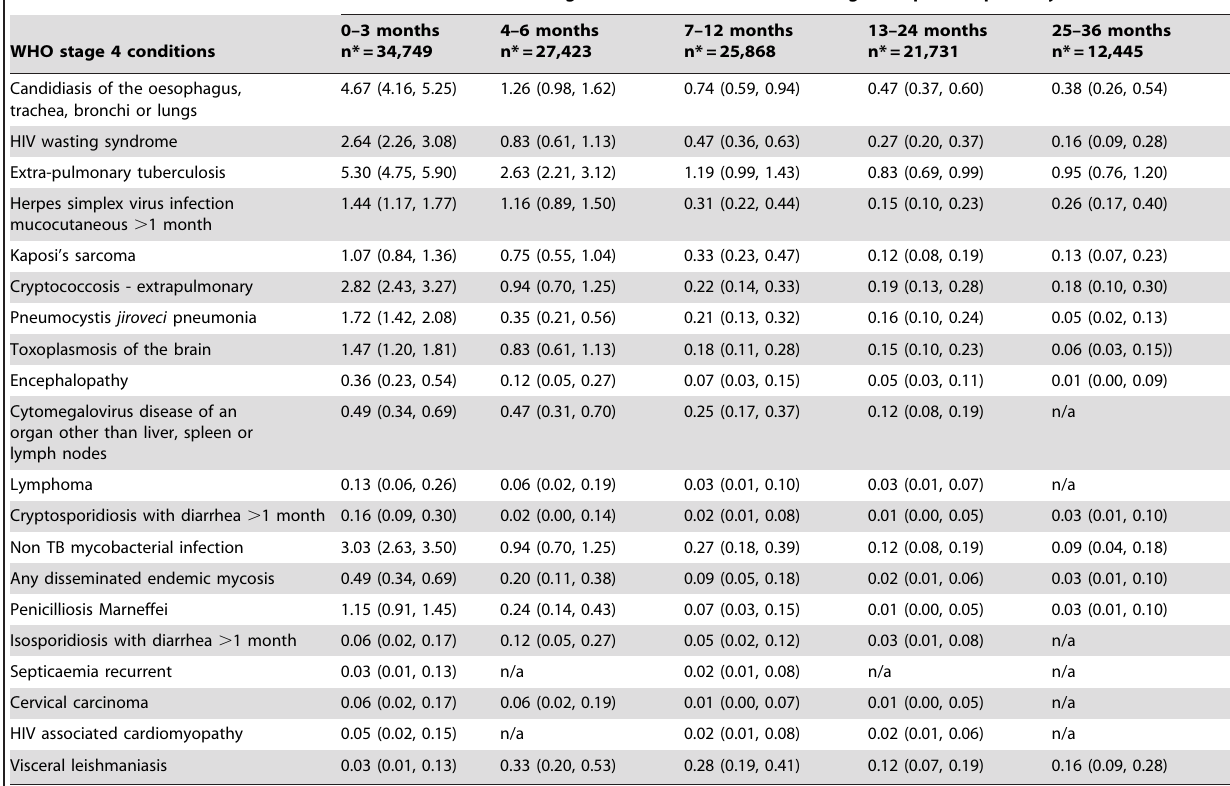
Table 3. Disease specific incidence over 36 months for selected WHO Stage 4 conditions.